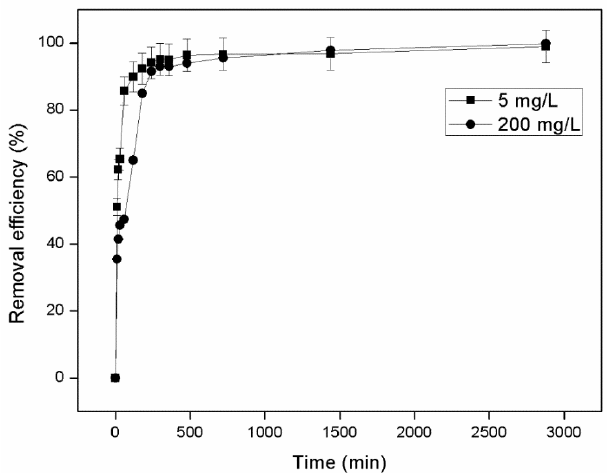
Figure 2. Effect of contact time on ammonium removal (5 and 200 mg/L NH 4 + -N, T = 25 °C, 200 rpm, 50 g zeolite/L, 4 – 5mm). Error bars indicate standard deviation of triplicate